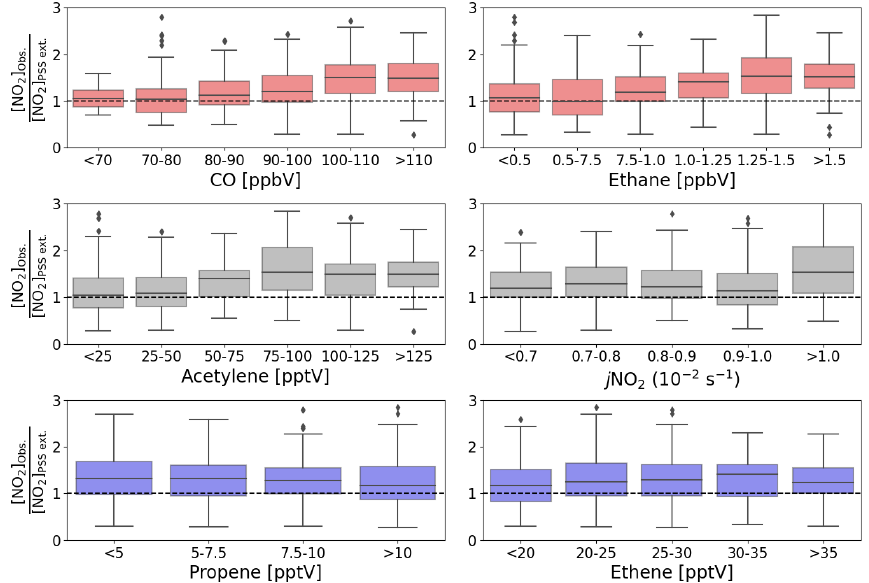
Figure 5. Box plots of midday (12:00–15:00UTC, local + 1) daily averages of [NO 2 ] Obs . / [NO 2 ] PSS ext . from July 2017 to June 2020 plotted against intervals of five different measured precursors for either HO 2 or RO 2 and j NO 2 . The black dashed lines represent a ratio of